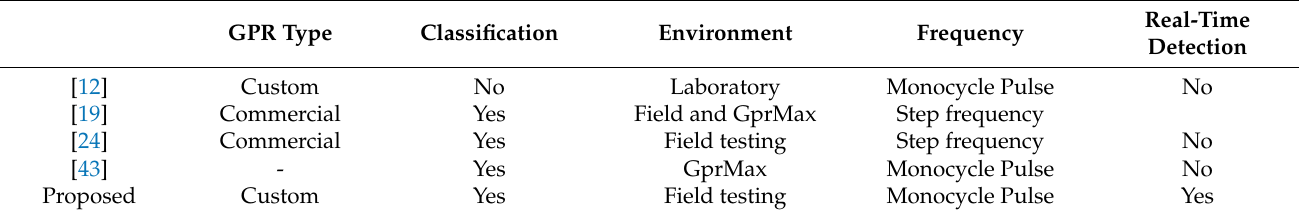
Figure 10. Shift procedure of the B-scan image.